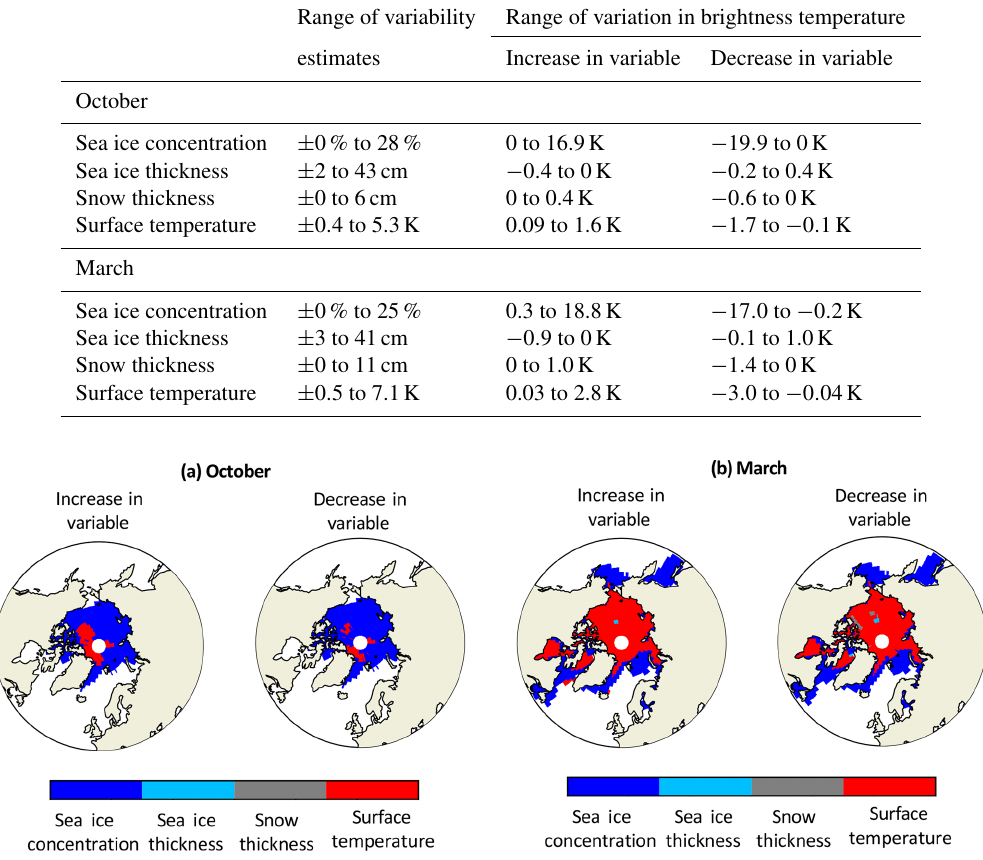
Figure 5. The variables that have the highest absolute mean effect on the brightness temperature in October (a) and March (b) when their variability field (see Table 1 and Fig. B1) is added to (first and third columns) and subtracted from (second and fourth columns) the input variable. These results are inferred from the SICCI2 assimilation run. Inspired by Fig. 5 in Richter et al.